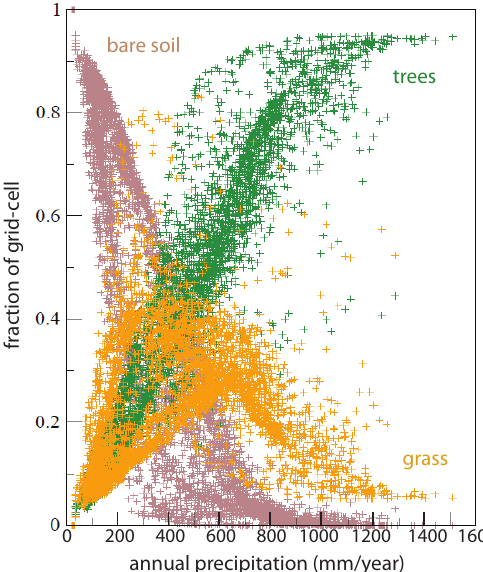
Figure 5. Vegetation cover simulated for present day with LPJ- LMfire over southern Africa: fraction of a grid cell occupied by bare soil (brown), trees (green) and grass (yellow) vs. the total an- nual precipitation on the same grid